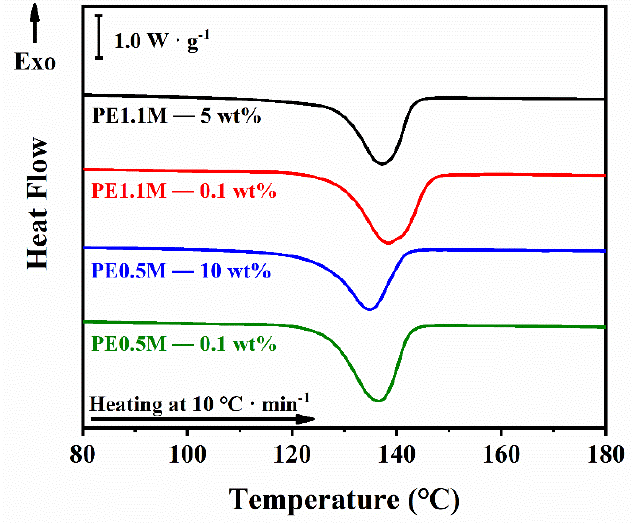
Figure 2. DSC plots four samples with a 10 ◦ C · min -1 heating rate in a dry nitrogen atmosphere. For exact values, please refer to Table 1. Table 1. Melting point ( T m ), mass crystallinity ( X c ) and lamellar thickness ( l ) of all the samples obtained from DSC. The fraction of the crystalline phase at 30 ◦ C ( f c, 30 ◦ C ) was fitted from the low-field